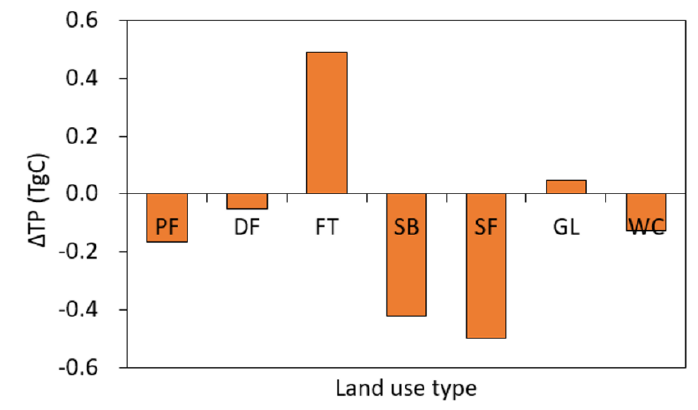
Figure 10. The impacts of different land-use types on the change of TP ( ∆TP ) in the areas with land-use change.